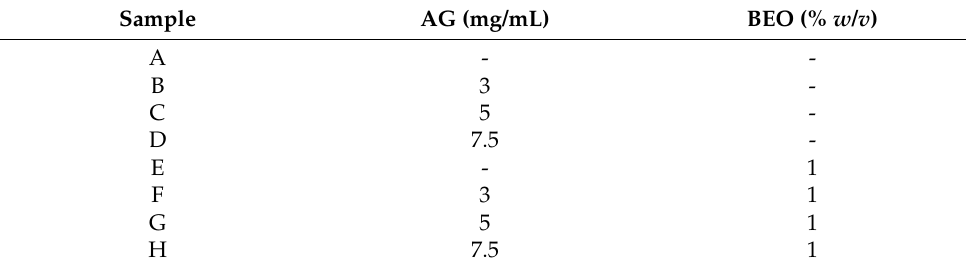
Table 1. Composition of ultradeformable nanocarriers